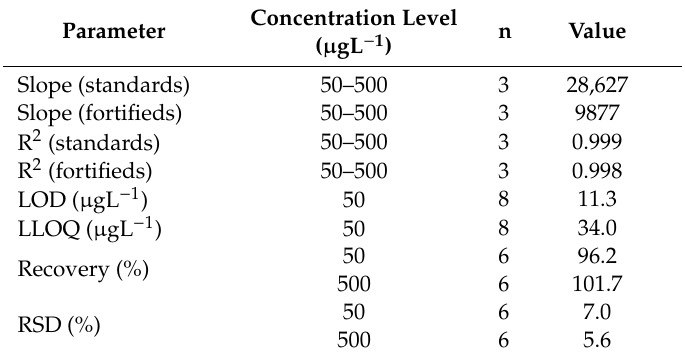
Table 3. Slope of regression, linearity, limit of detection (LOD), lowest limit of quantification (LLOQ), recovery, and